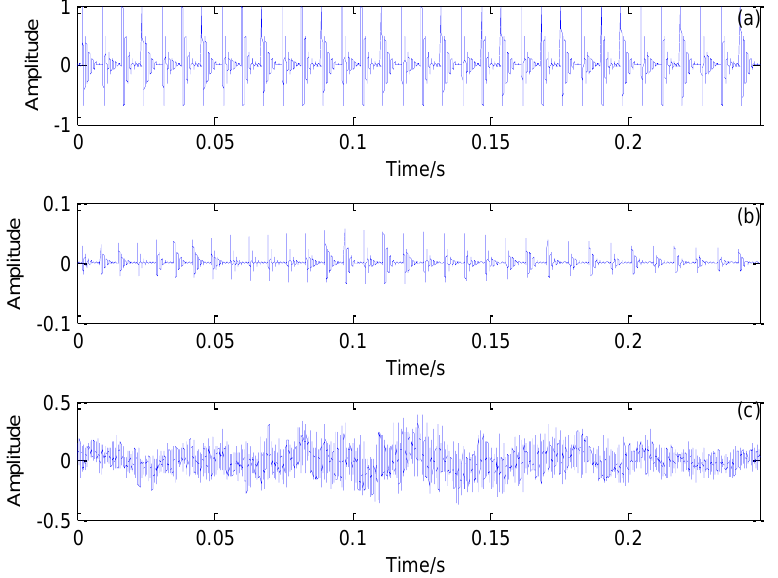
Figure 12. Results obtained using the proposed method: ( a ) the optimal periodical transient model; ( b ) the optimal Doppler transient model and ( c ) the outer race fault